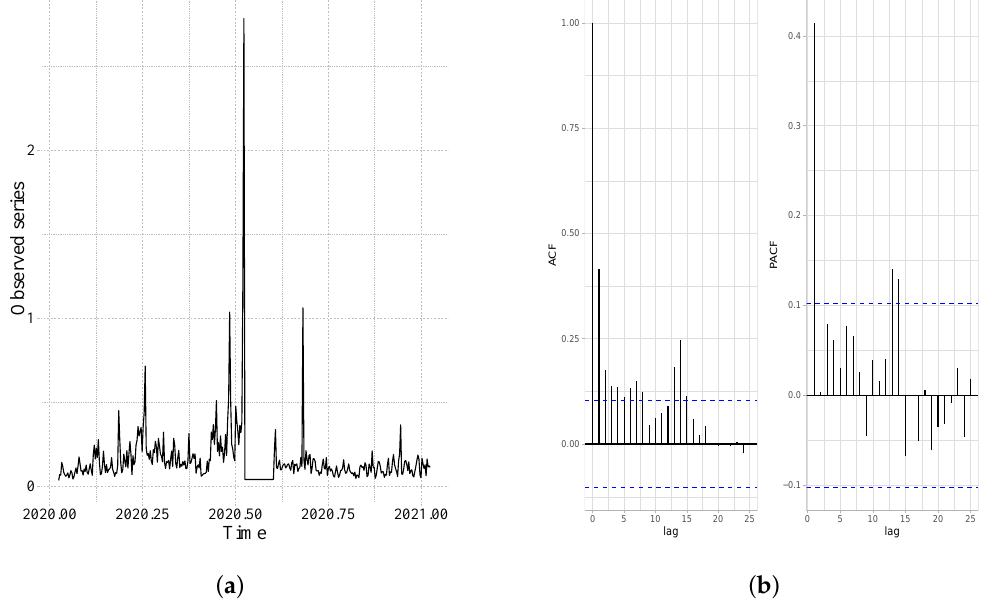
Figure 3. USDT series and its sample ACF and PACF. ( a ) Real series. ( b ) (ACF, PACF) of the USDT real series.